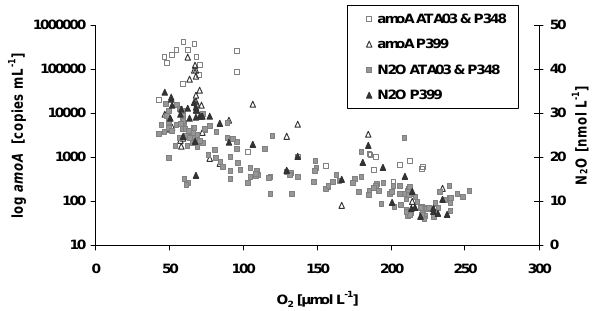
Fig. 4. Archaeal amoA and N 2 O versus O 2 in the ETNA (data from the cruises ATA03, P348 and P399/2). A similar trend has been de- tected during the three cruises.